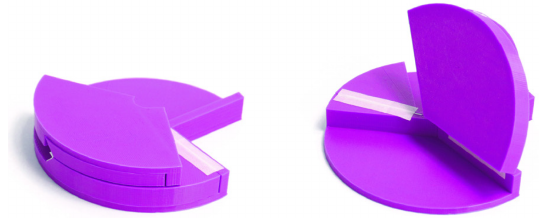
Figure 27. Inverted sector panel ThUDS with thickness added and removed to allow for flat foldability. Shown in flat-folded and de- ployed states.